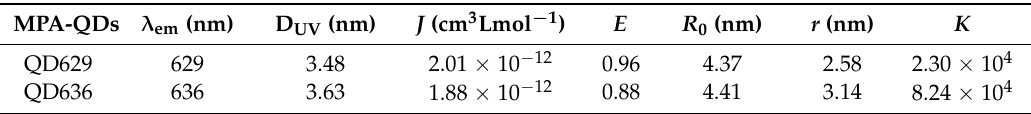
Table 1. Calculated overlap integrals ( J ), FRET efficiencies ( E ), Förster distances ( R 0 ), distance between the donor and the acceptor ( r ), and binding constant ( K ) obtained by Equations (S1)–(S4) (Supplementary